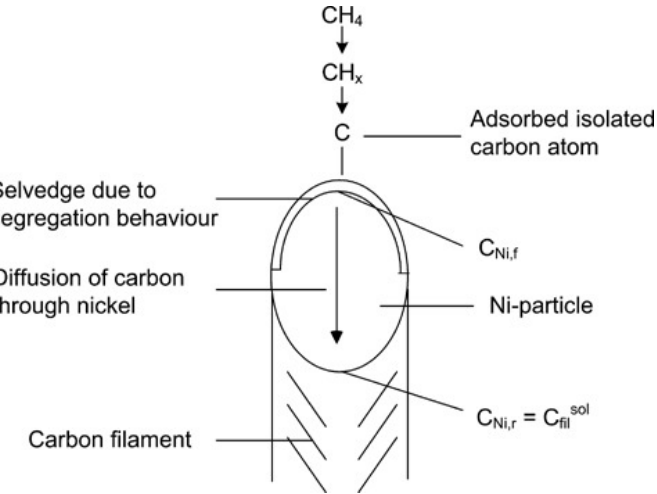
Figure 10. Schematic diagram of the “tip-growth” mechanism of carbon filament [11].